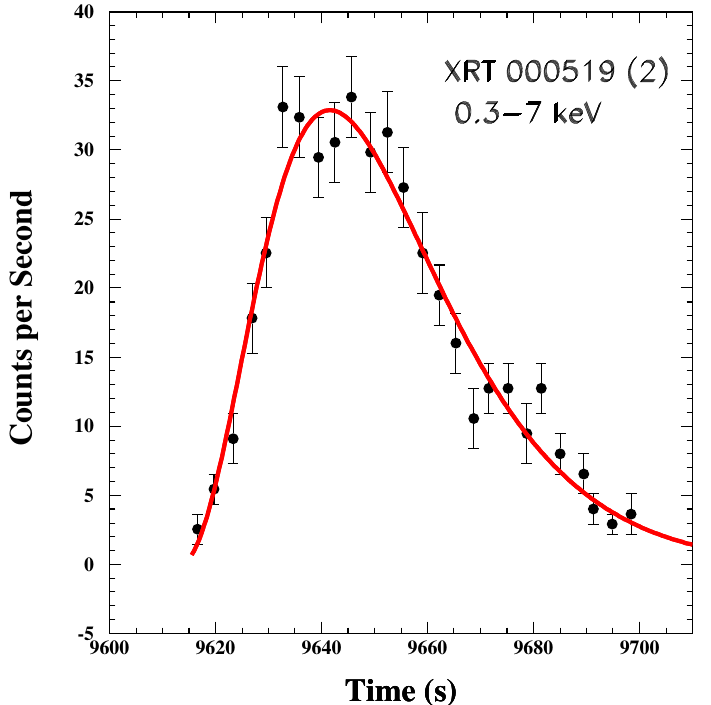
Figure 29. The light curve of the second pulse of XRT 000519 [77] and the CB-model’s predicted shape of Equation (24) with the best-fit parameters ∆ = 35.54 s, τ = 28.58 s, E p ( 0 )= 27.11 keV (for time t since 9613.28 s); χ 2 /dof = 1.28.